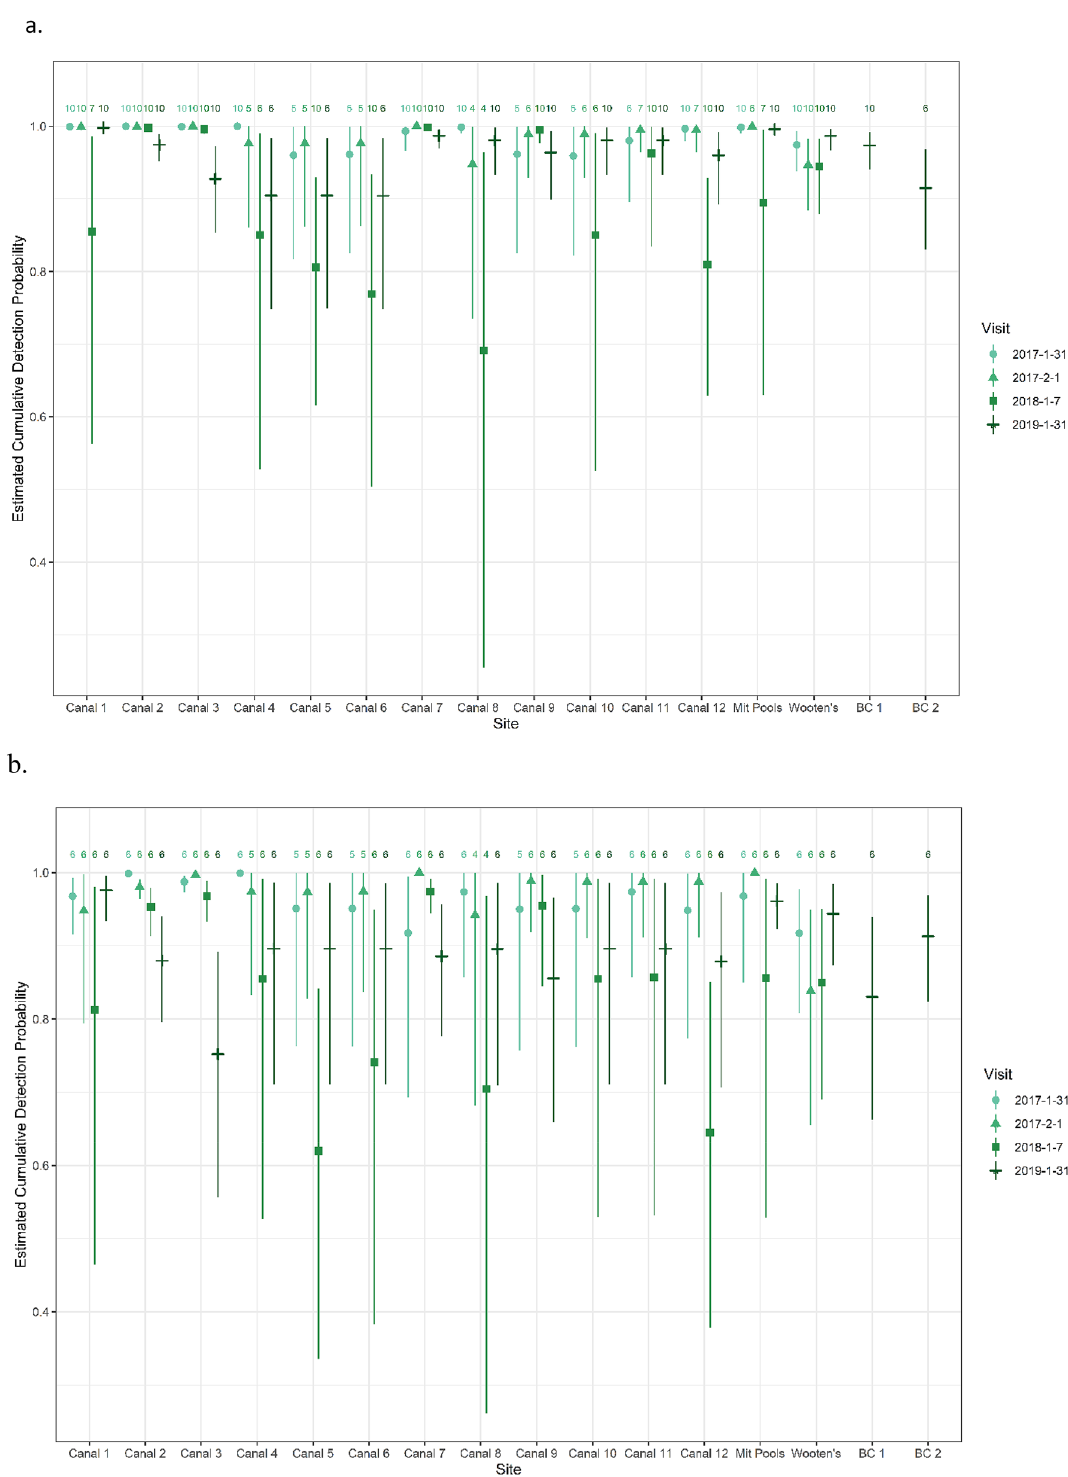
Figure 6. Estimates of the cumulative probability of detecting a manatee using ( a ) 6 min and ( b ) 10 min of video, by site and visit. Symbols indicate means (point estimates) and lines 95% credible intervals. The numbers at the top of the graphs indicate the total number of minutes in each survey. Site “Mit Pools” are the mitigation pools and “BC” indicates Big